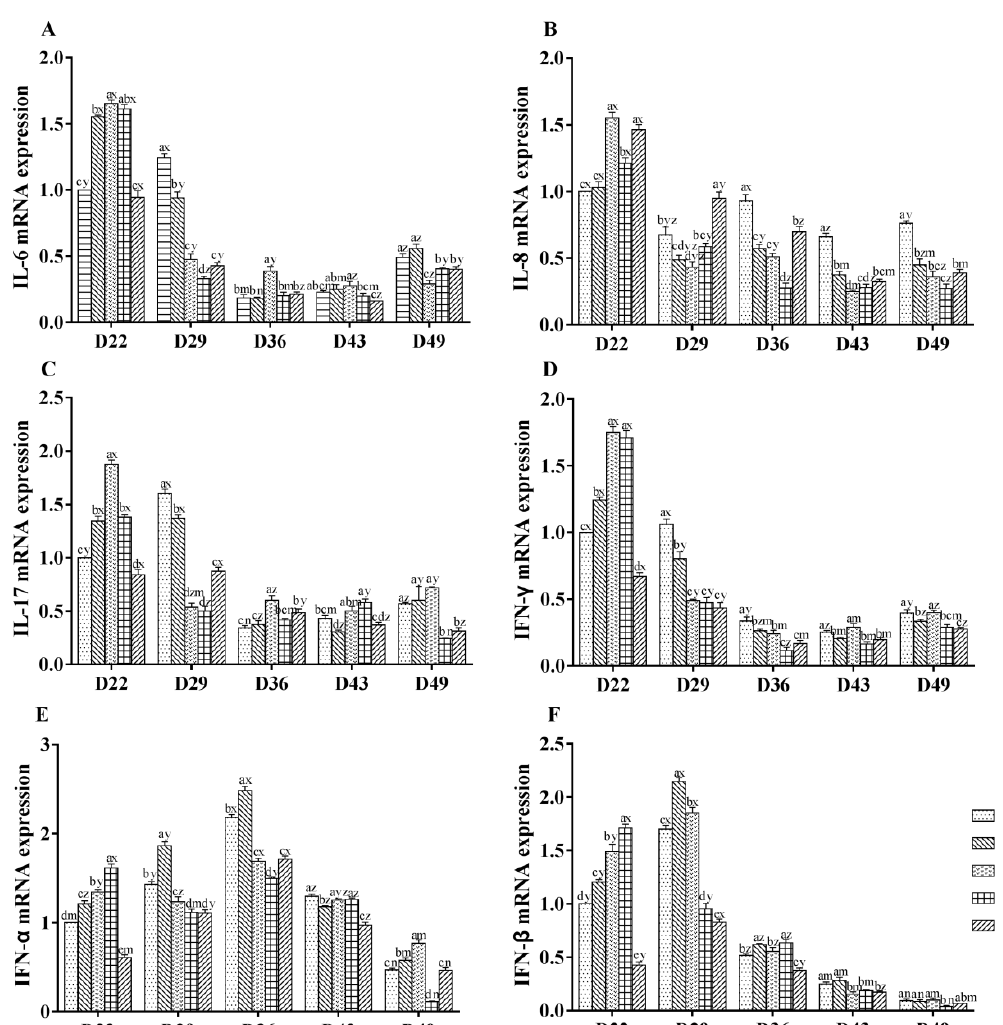
Figure 2. The mRNA expression levels of IL-6 ( A ), IL-8 ( B ), IL-17 ( C ), IFN- γ ( D ), IFN- α ( E ), and IFN- β ( F ) in broiler bursae of Fabricius at D22, D29, D36, D43, and D49 (where D denotes “days of age” and the numeral indicates the day number, e.g., D22 refers to 22 days of age). a, b, c, d, and e represent significant di ff erences among groups at the same sampling time ( p < 0.05). x, y, z, m, and n represent significant di ff erences among di ff erent sampling time in the same group ( p < 0.05). CS3, CS4, CS5, and CS6 refered to the intermittent and mild cold stimulation of 3 ◦ C below the conventional feeding temperature for three-, four-, five-, or six-hour periods at one-day intervals,